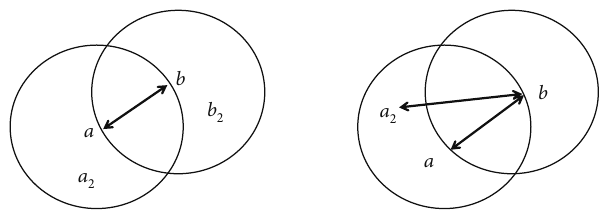
Figure 2: Con fi dence calculation diagram of pairwise fusion